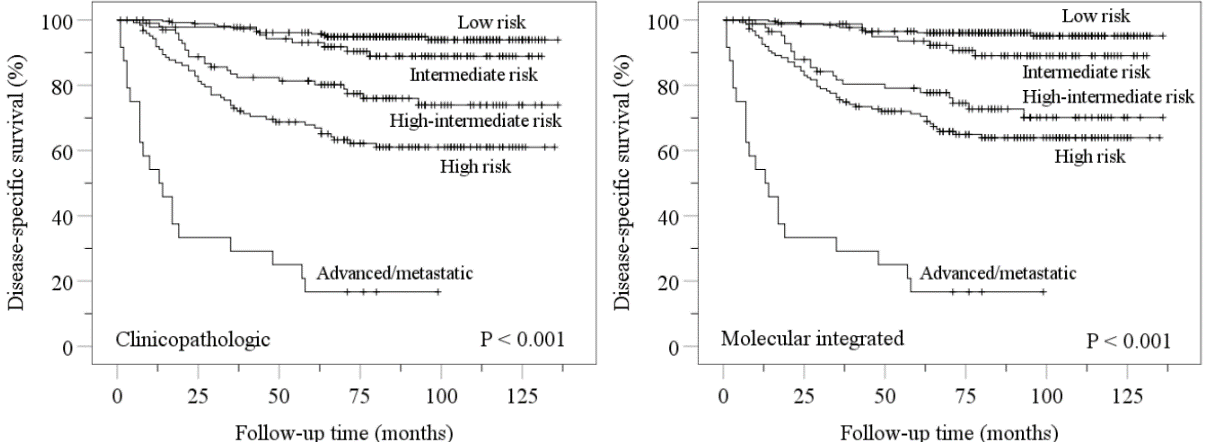
Figure 2. Kaplan – Meier estimations for disease-specific survival according to ESGO-ESTRO-ESP 2021 clinicopathologic and molecular integrated risk classification systems. Nonsignificant p values for pairwise comparisons were as follows: clinicopathologic low vs. intermediate, p = 0.120; molecular integrated low vs. intermediate, p = 0.056; molecular integrated high-intermediate vs. high, p = 0.207.